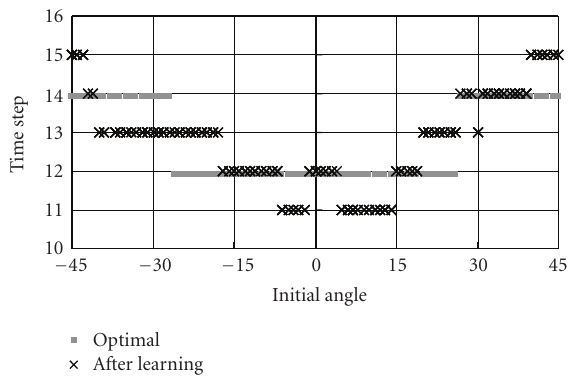
Figure 10: Catch timing when the initial motion of the object varies. The optimal catch timing under the assumption that the velocity is not reduced at the time of bounce in the invisibility area is also plotted to show whether the agent can consider the reduction in velocity due to the bounce by comparing it with Figure 9.